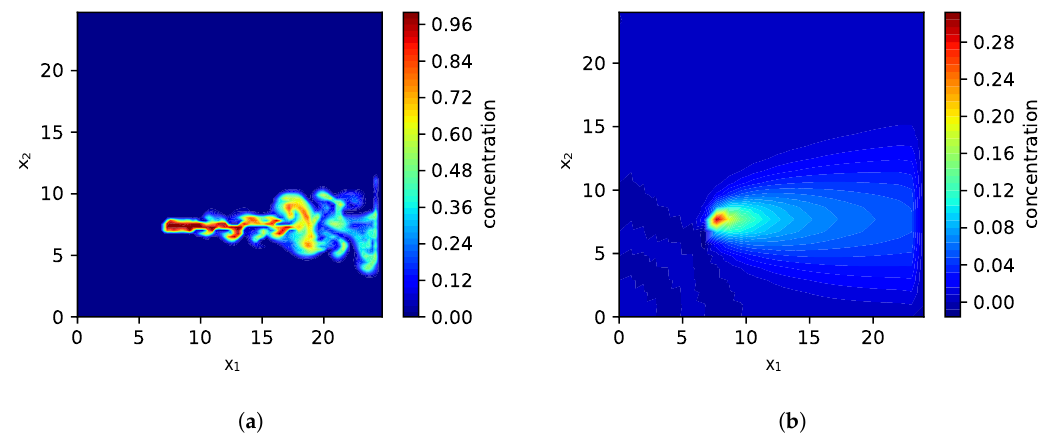
Figure 1. Comparison of the simulated gas concentration based on mantaflow in ( a ) and the PDE (1) in ( b ); While in ( b ) the space discretization is 26 × 26, in ( b ) the resolution of the simulation is 96 × 96 for a more accurate visualization.